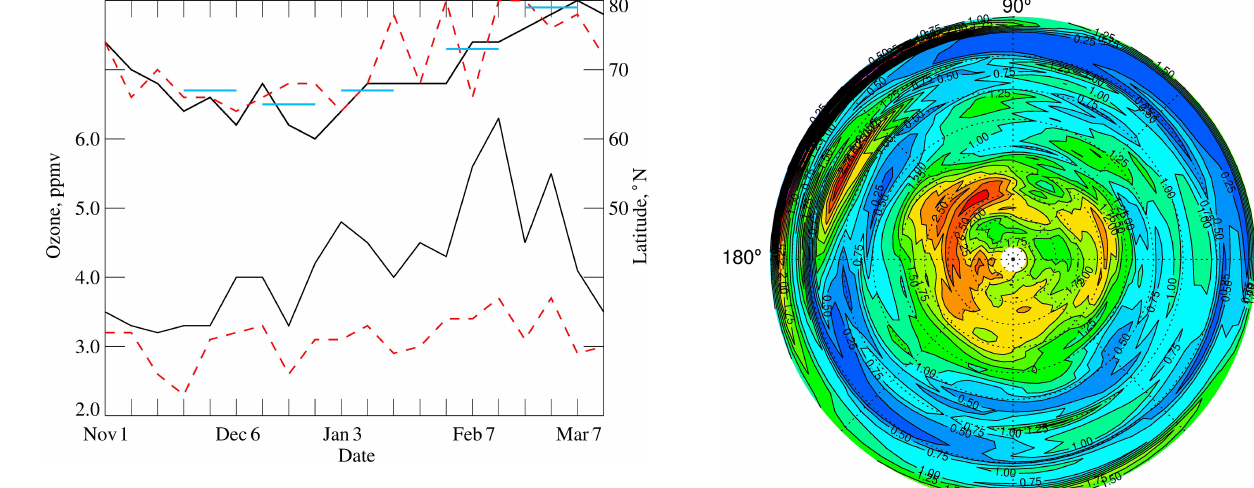
Figure 14. Time series of peak V6 ozone (bottom two curves) and its latitude location (top two curves) at 0.022hPa. Dashed red curves are for combined ozone, while solid curves are for descend- ing (nighttime) ozone only. Horizontal blue lines indicate the lati- tude of the terminator.